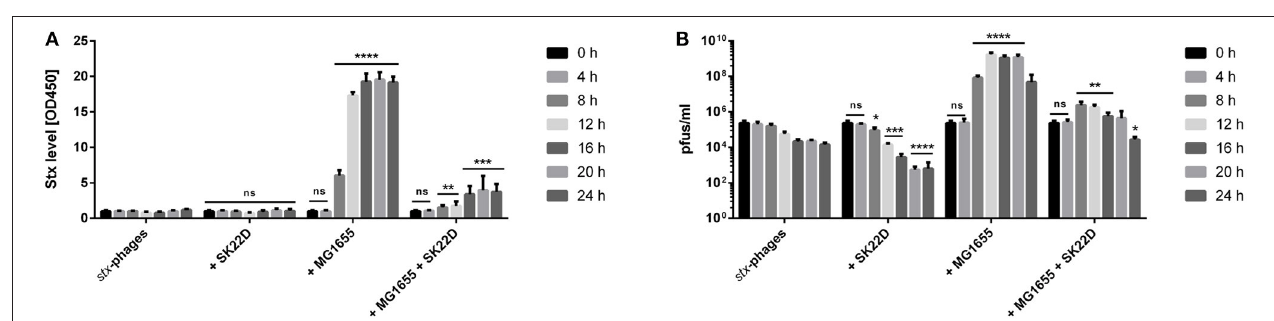
FIGURE 7 | Kinetics of MG1655 stx -phage infection or protection by SK22D. stx -phages were incubated in mono-/co-/or tricultures with the microcin negative EcN strain SK22D and/or the K-12 strain MG1655 at a starting MOI of 1:10:10 ( stx -phages: SK22D: MG1655) for 24 h, static. (A) The Stx level of the filtrate was determined with the Ridascreen ® Verotoxin Elisa and (B) the pfus/ml were evaluated with a Phage Plaque Assay (PPA) every 4 h. ns, not significant, * p < 0.05, ** p < 0.01, *** p < 0.001, and **** p <